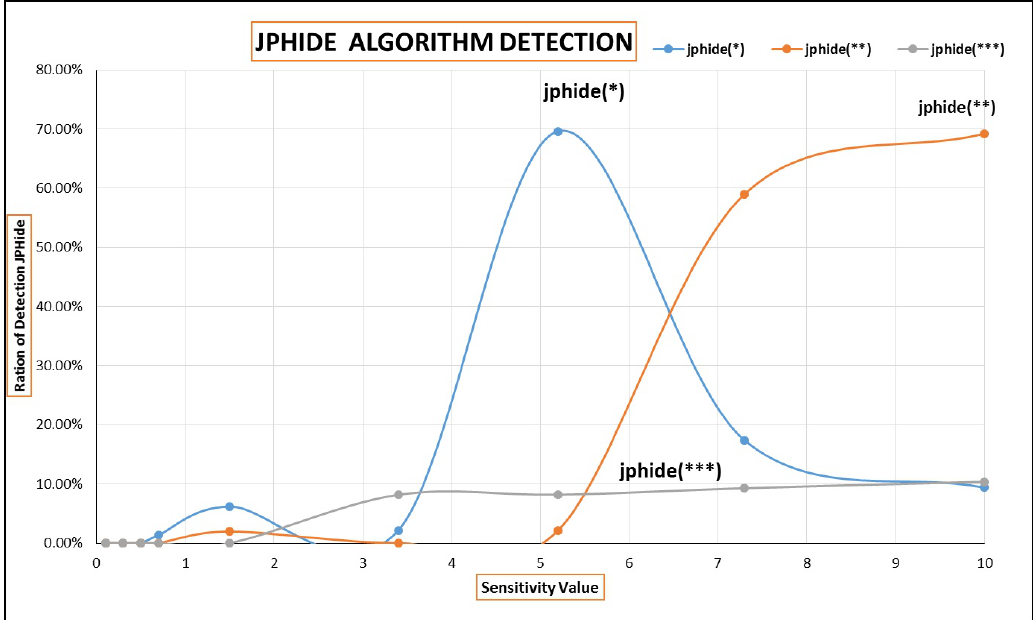
Figure 2. Changes in the jphide rate with different sensitivities for seam carve manipulated